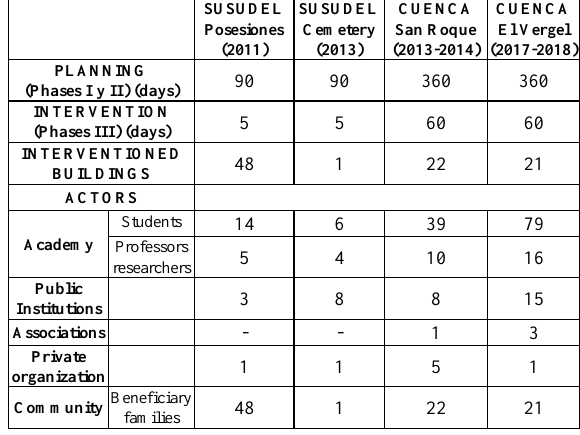
Table 1. Comparative maintenance